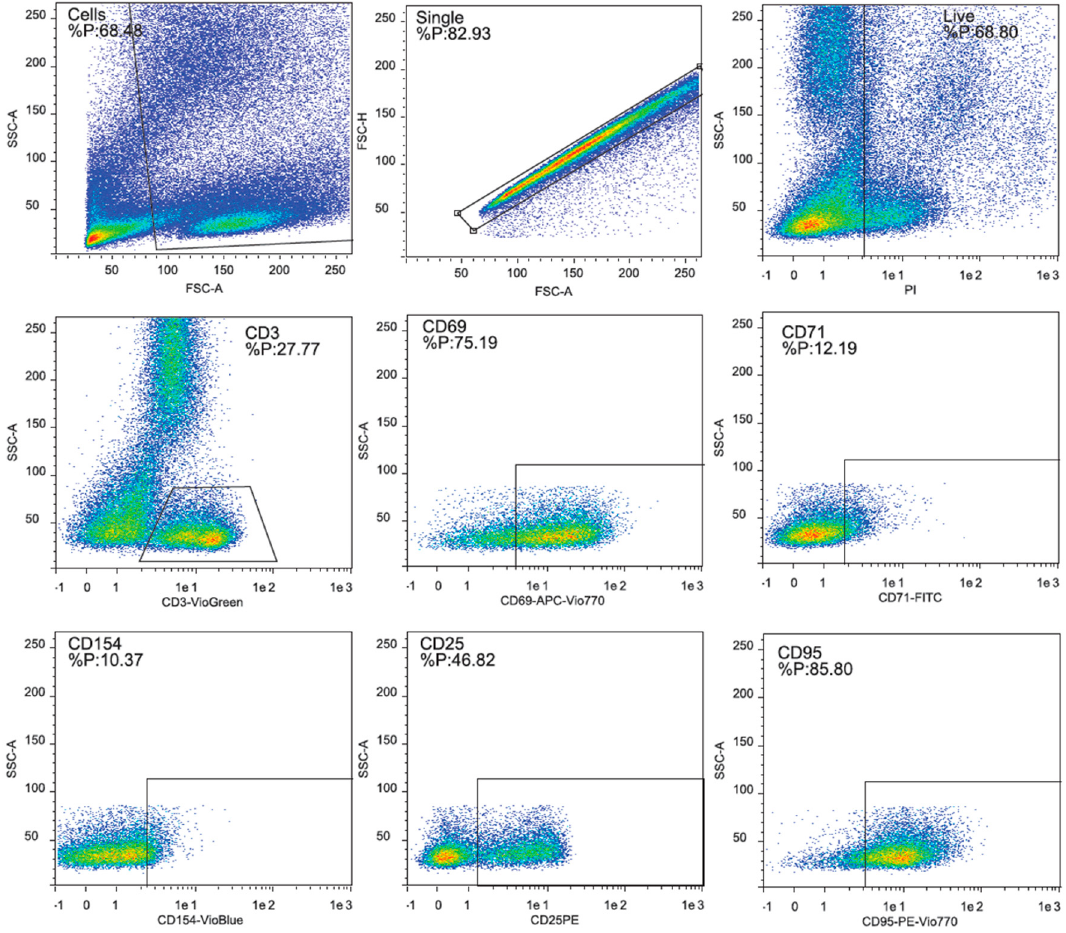
Figure A1. Gating strategy for surface marker expression on CD3+ T cells.